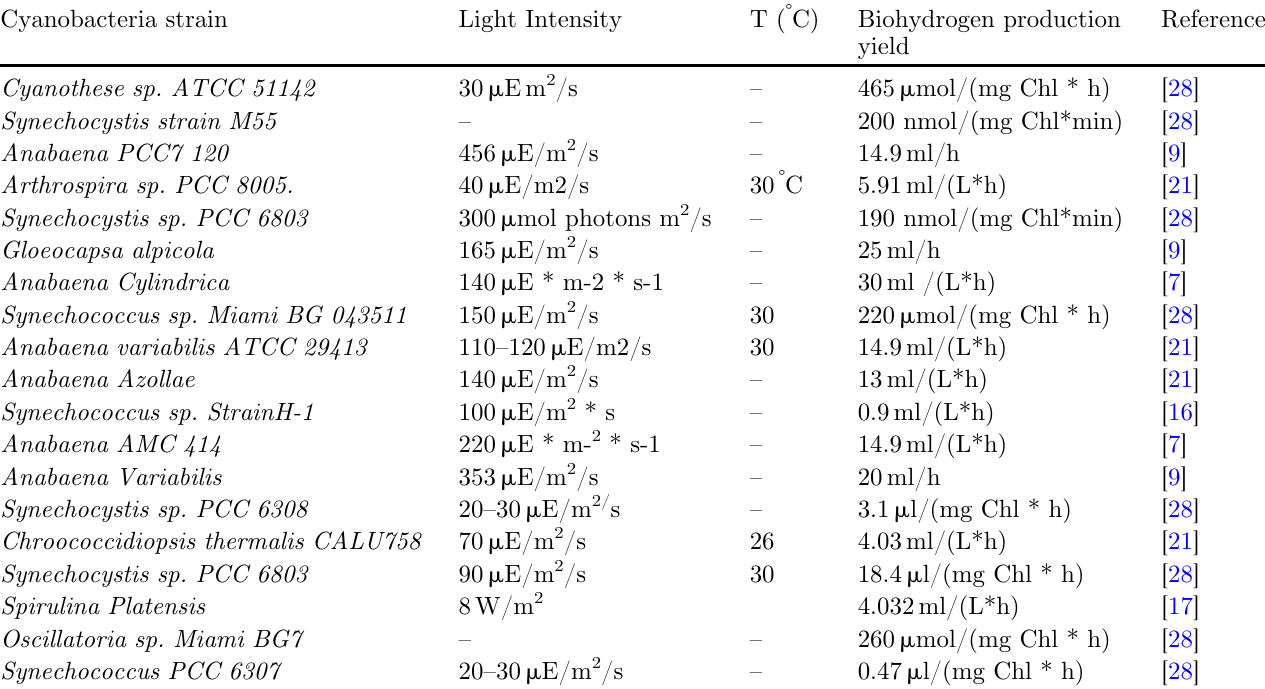
Table 13. Cyanobacteria biohydrogen productivity according to